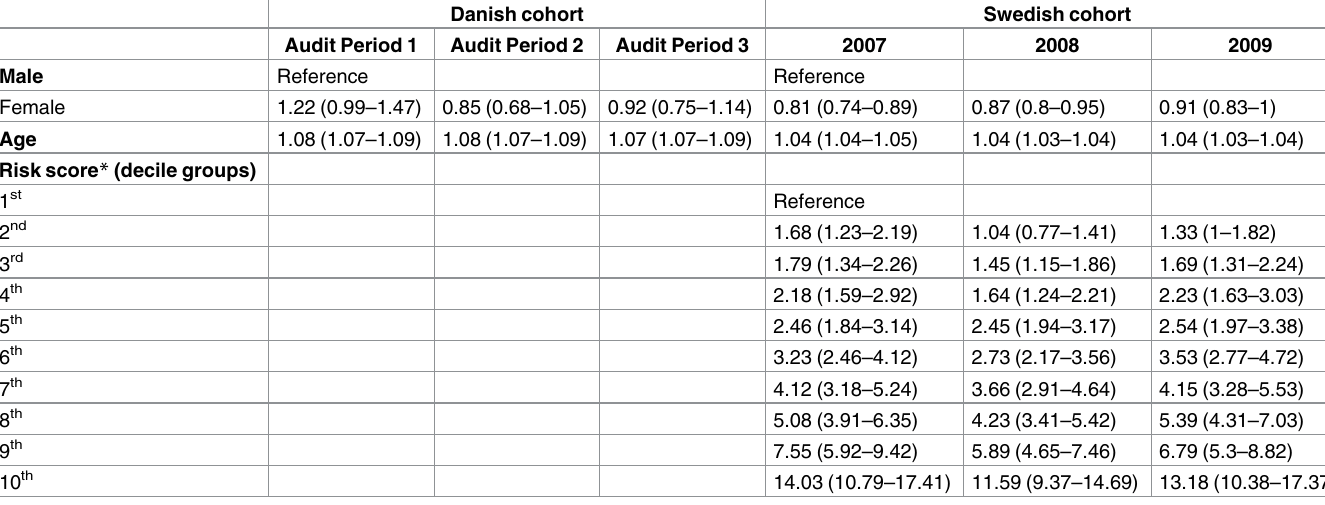
Table 2. Measuresof association (fixed effects)obtained by two-level (patients and hospitals departments) multilevel logistic regression model- ling one-year mortality for heart failure patients treated in clinical departments. Values are odds ratios (OR) and 95% confidenceintervals